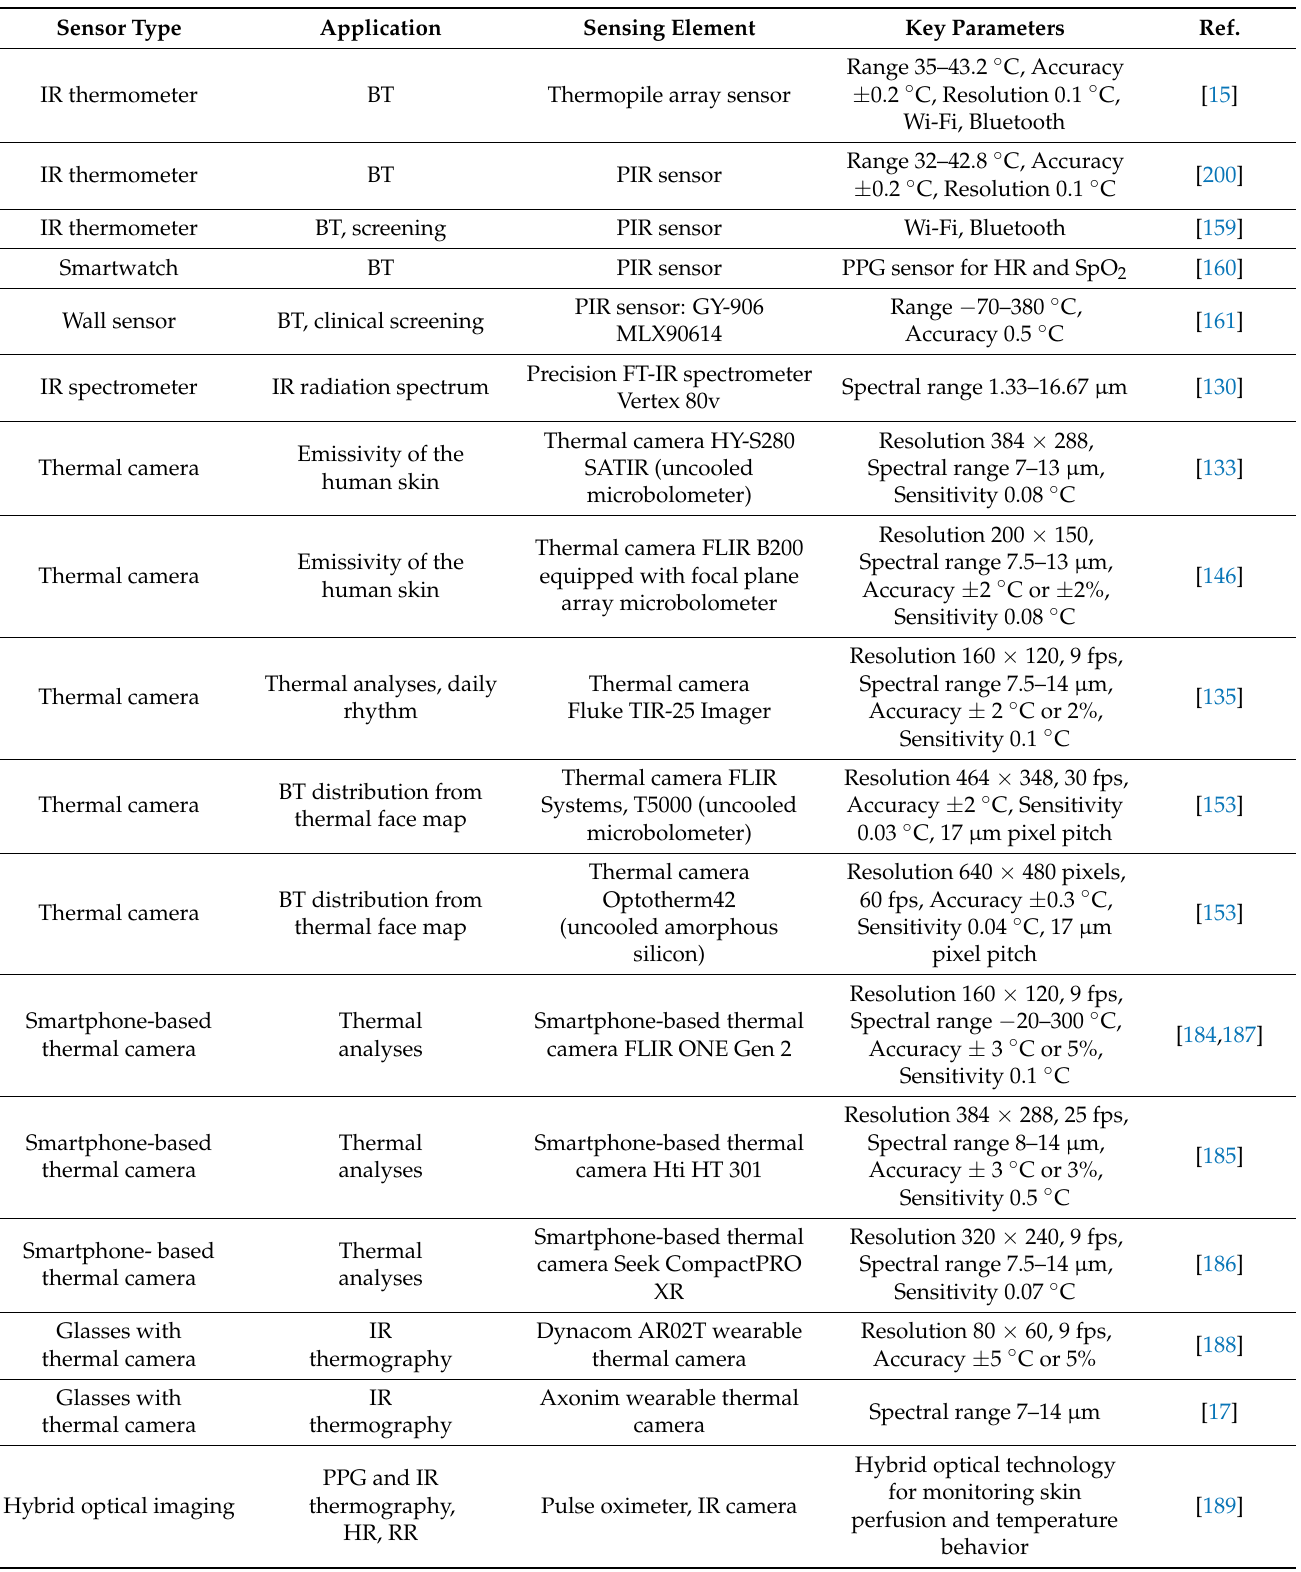
Table 2. Radiation